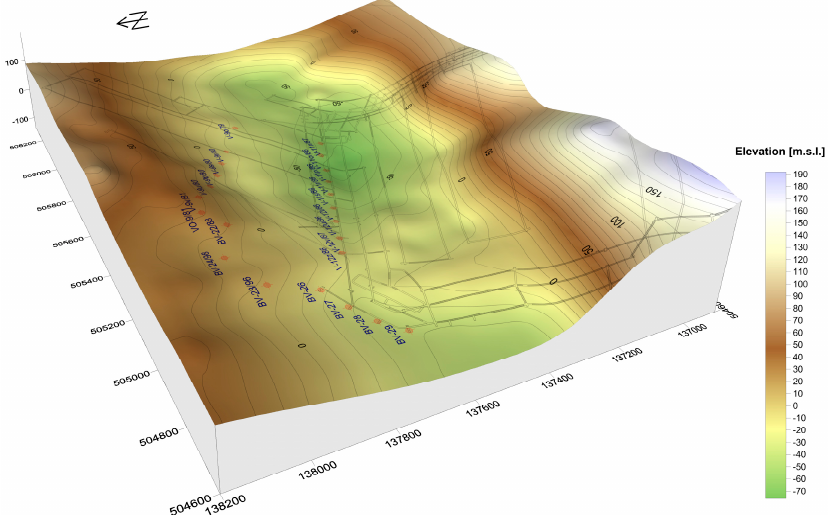
Figure 2. A 3D elevation map of the Pl-1 and Pl-2 variety of Pliocene water-carrying sands in the year 2007. Red circles present pumping wells affected from mining works.